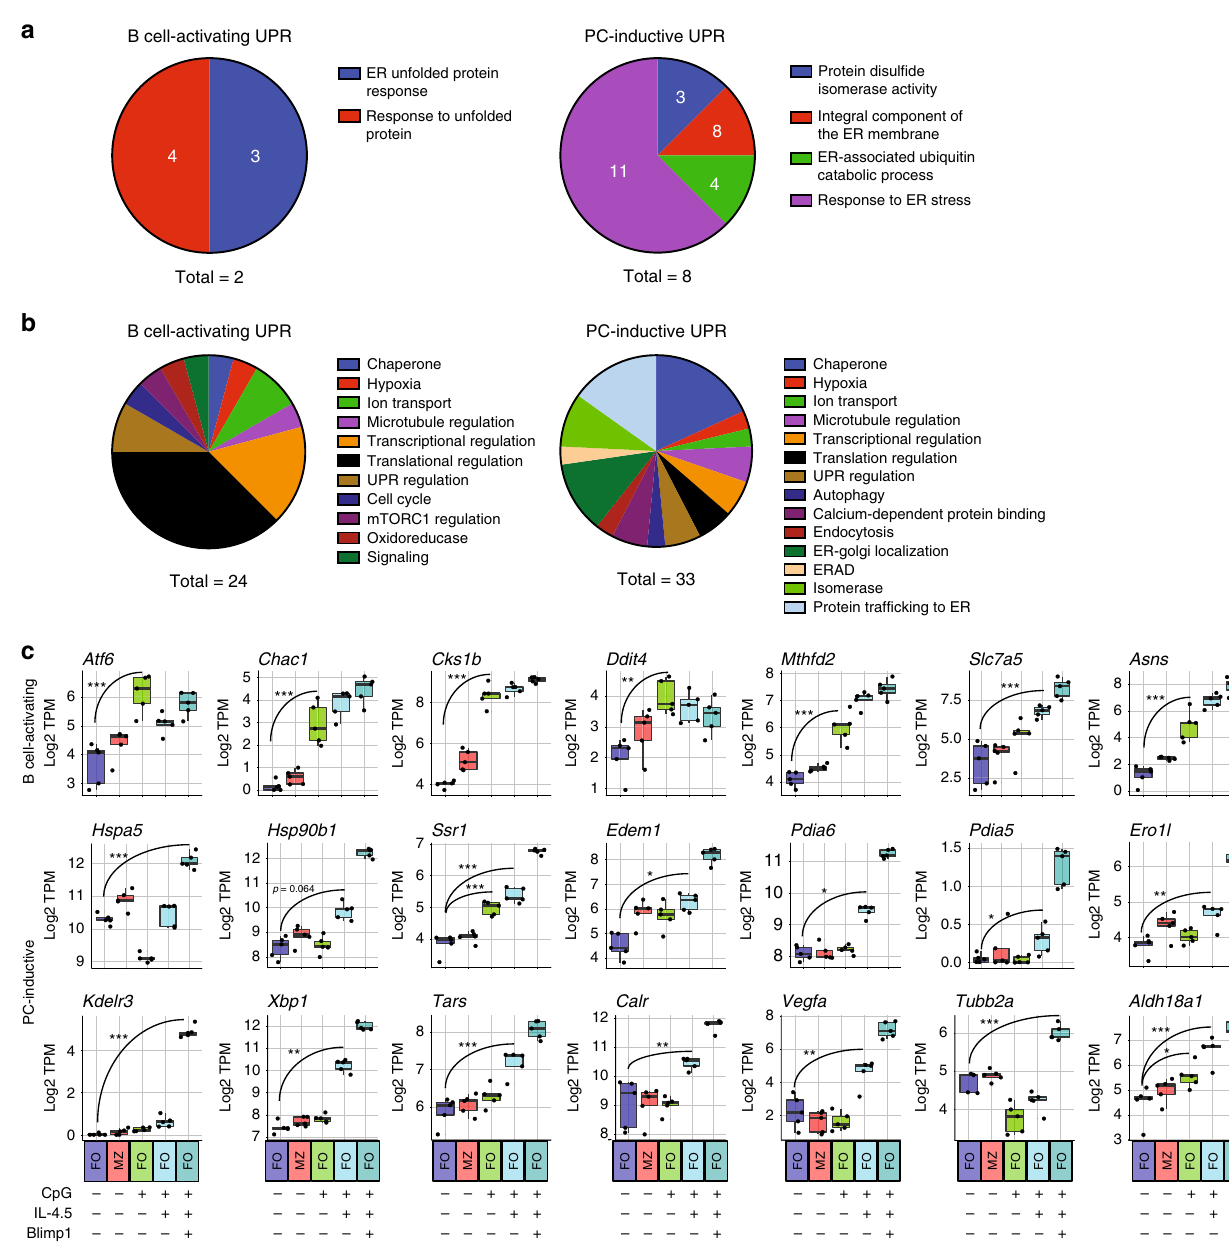
Fig. 4 Qualitative differences in activation induced and plasma cell-differentiation induced UPR gene sets. a Gene sets de fi ned in Fig. 3c were subjected to gene ontology (GO) cluster-enrichment analysis. Biological process, cellular compartment, and molecular function annotation was used to determine clusters of enriched terms. Only those terms with a p value < 0.05 were used in clustering. The term with maximum number of contained genes was chosen as the founder term and the number of genes is shown in the wedge. b Each gene in the gene sets de fi ned in Fig. 3c was annotated by functional category. Wedge indicates the number of genes in the term as part of the total genes in the gene set. c From the RNA-seq dataset described in Fig. 3, the Log 2 TPM magnitude of expression of selected genes in each gene set is shown as mean (line), 75%CI (box) and 95%CI (whisker) as well as individual data points (jitter). (* p < .05, ** p < .01, *** p < .001; differential expression statistic: BH-adjusted p -value — eBayes method — Limma). PC plasma cell. Source data are provided as a Source Data fi